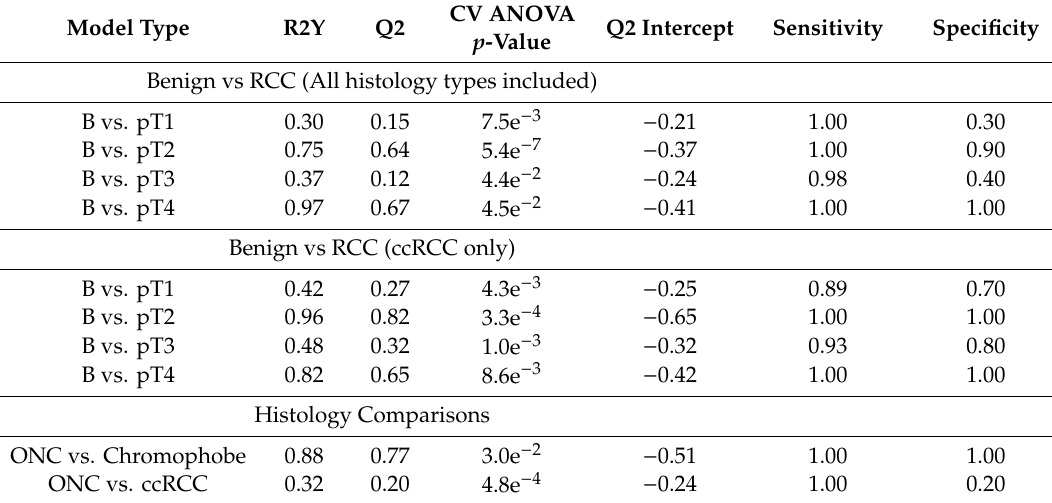
Figure 2. NMR Orthogonal Partial Last Squares Discriminant Analysis (OPLS-DA) score scatter plots distinguishing between benign and clear cell renal cell carcinoma. ( a ) benign versus stage 1 cancer cases; ( b ) benign versus stage 2 cancer cases ( c ) benign versus stage 3 cancer cases ( d ) benign versus stage 4 cancer cases along their orthogonal partial least squares (OPLS1) and partial least squares components (PLS1). The white spheres in ( b ) describe the 95% confidence interval of the Hotelling’s T-squared distribution and the orange and red dashed lines in ( a , c , d ) describe the 2SD and 3SD limits respectively. Table 2. Statistical metrics of group separation.